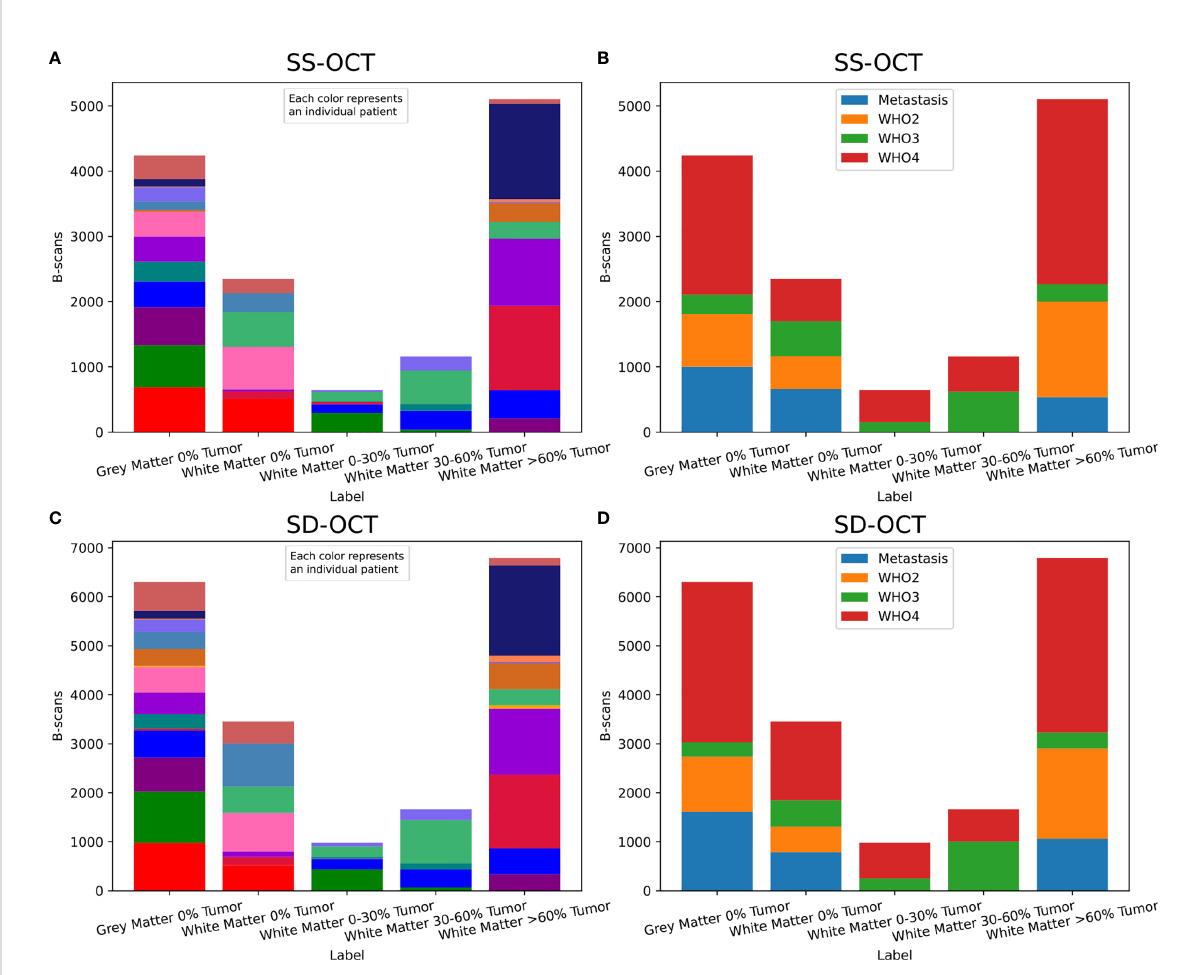
FIGURE 2 Distribution of the extracted B-scan patches among the different study patients [SS-OCT: (A) , SD-OCT: (C) ] and the diagnosed tumor types [SS- OCT: (B) , SD-OCT: (D) ]. For (A) and (C) the different patients were represented through different